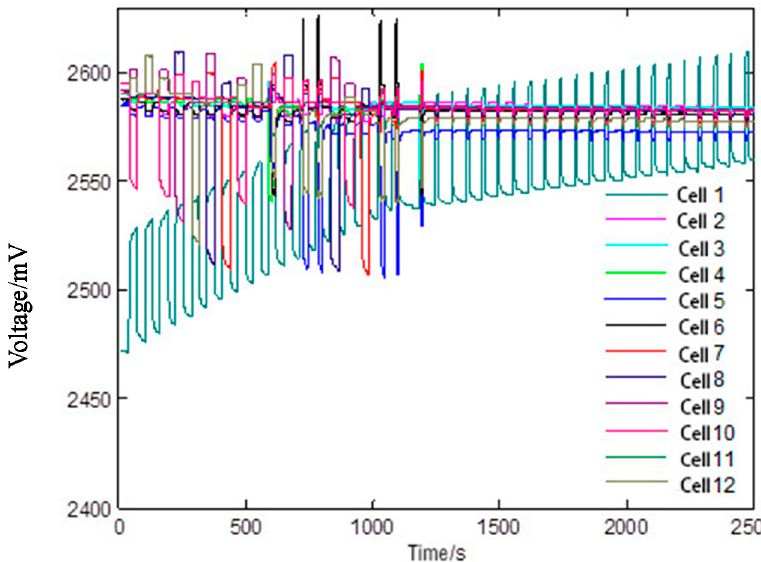
Figure 16. Voltage equalisation curves of the first battery